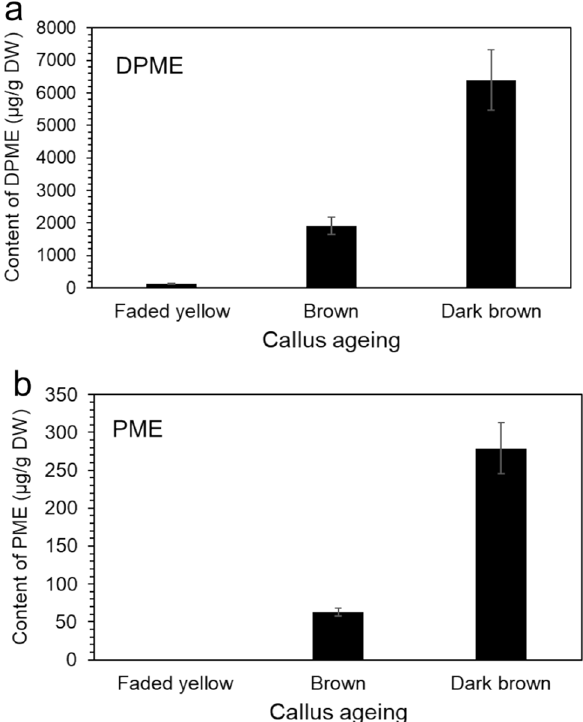
Figure 6. Enhanced accumulation of DPME and PME in P. strobus calli by prolonged incubation. The analysis results are presented as the means ± SEs of three independent experiments, each performed in technical